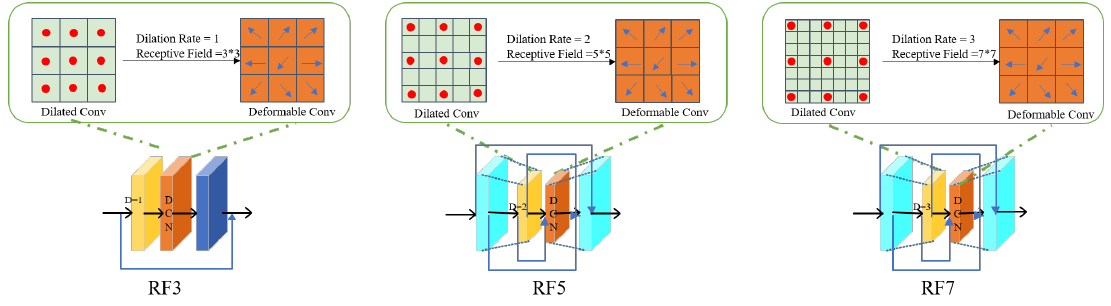
Figure 4. Three scales of the multi-scale RF module, expressed in the form of different receptive field